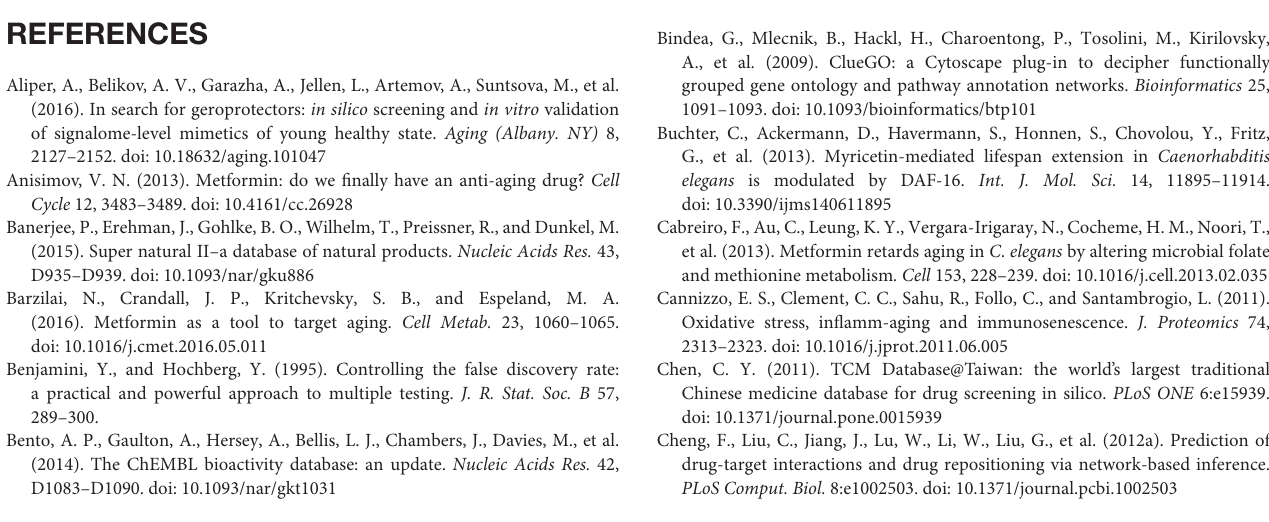
Table S7 | The detailed information for ClueGO analysis. Table S8 | List of predicted indications of natural products based on experimental drug-target network only and the pooled drug-target network from both computationally predicted and experimentally validated drug-target